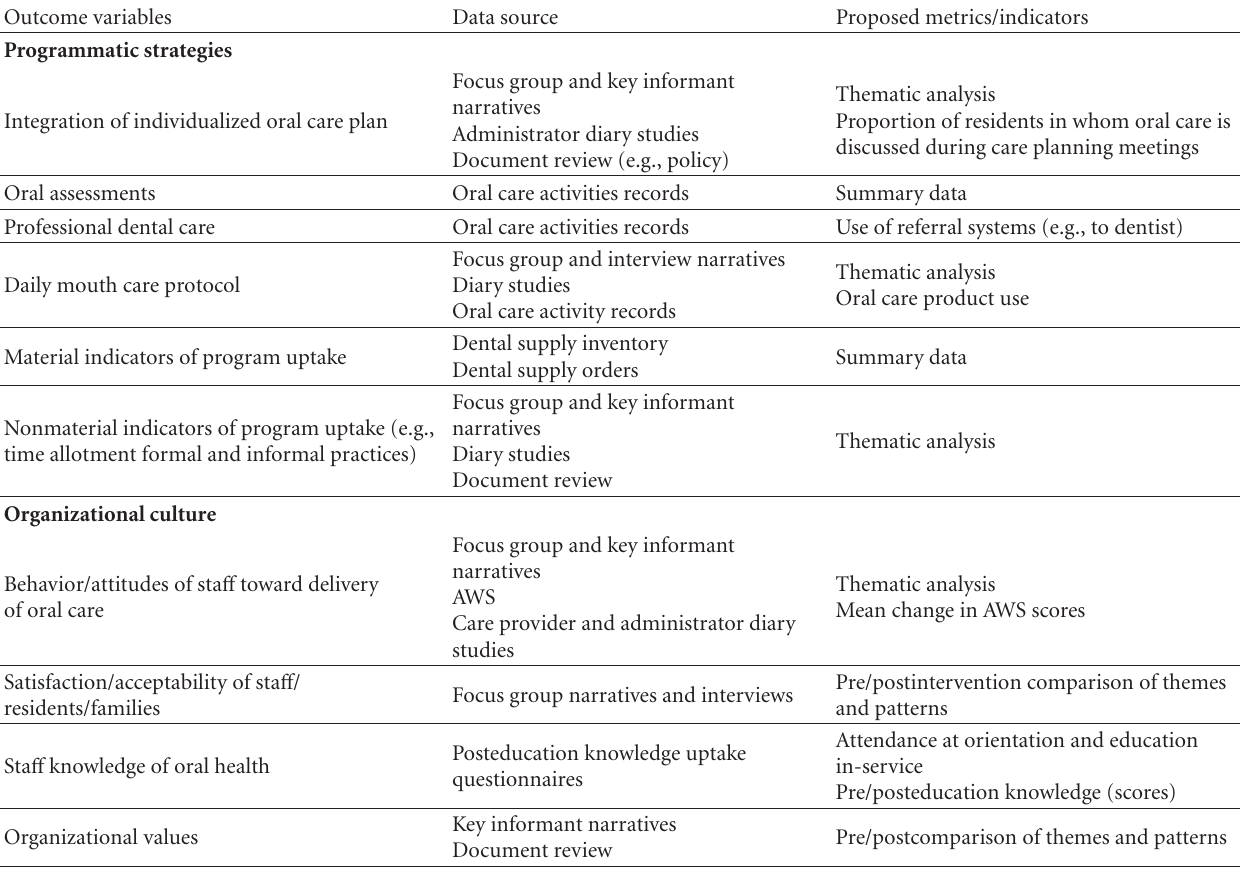
Table 3: Evaluation